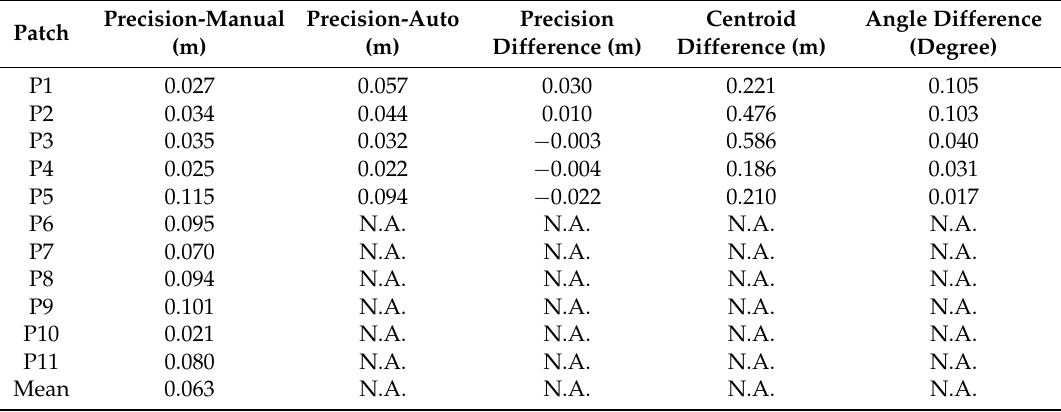
Table 12. Plane fitting precision, plane fitting precision difference, centroid difference, and angle difference values for building #3 (Spherical